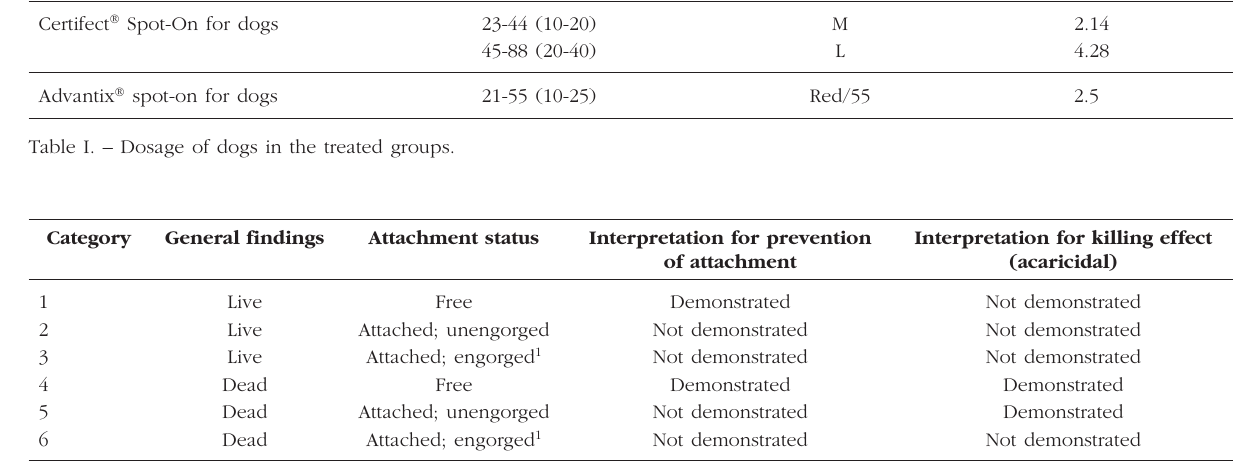
Table II. – Categorization of ticks for counting and